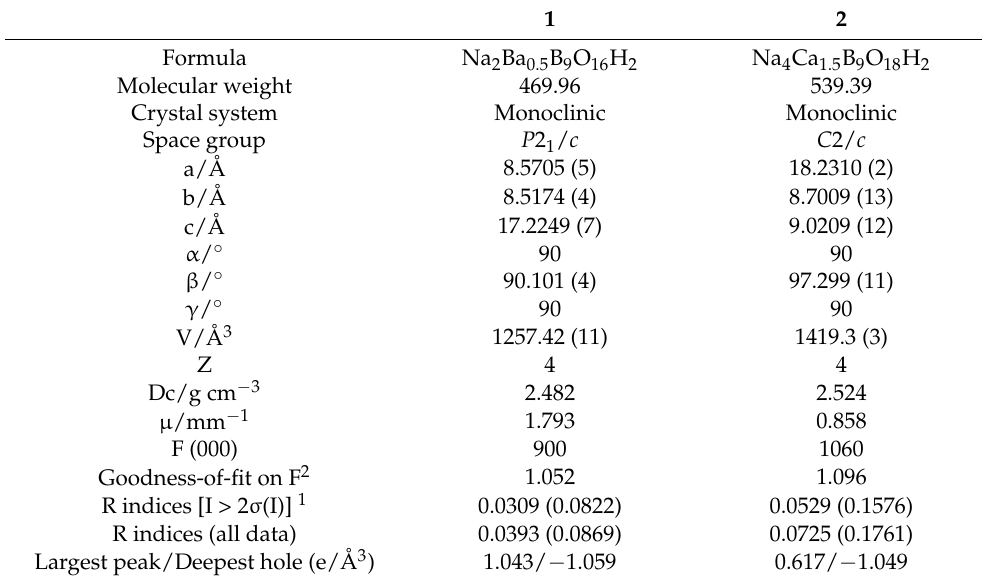
Table 1. Crystallographic data and structural refinements for 1 and 2